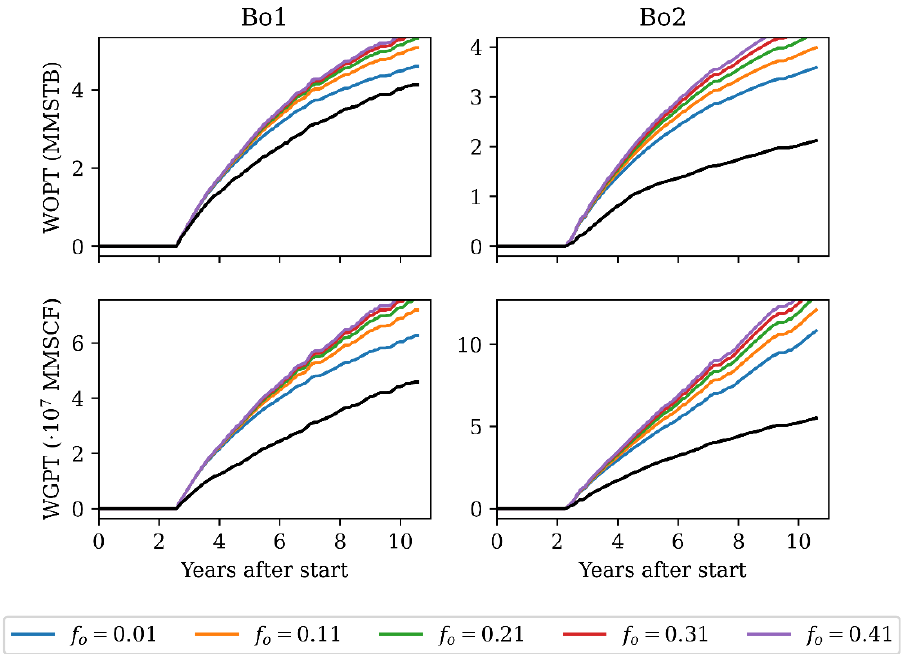
Figure 9. The production volumes for the Bo model, corresponding to the different relative permeabilities in Figure 7. Black lines denote historical data.